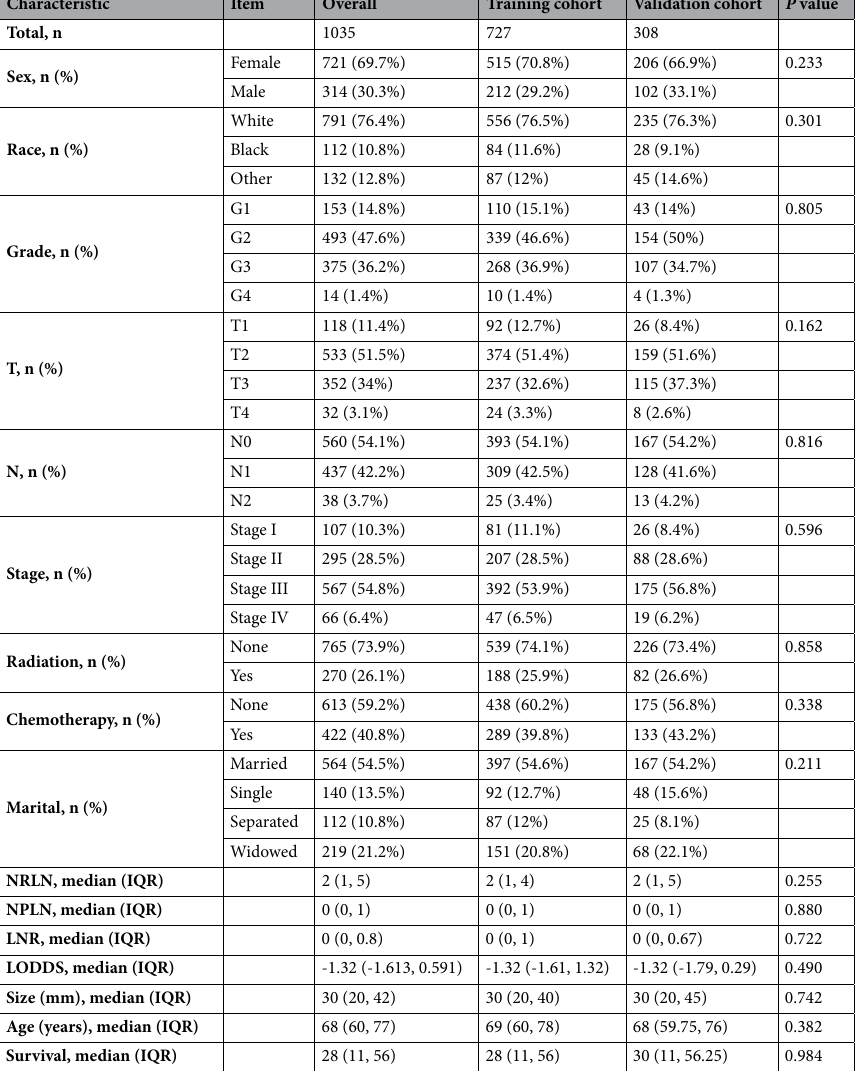
lymph nodes, IQR interquartile